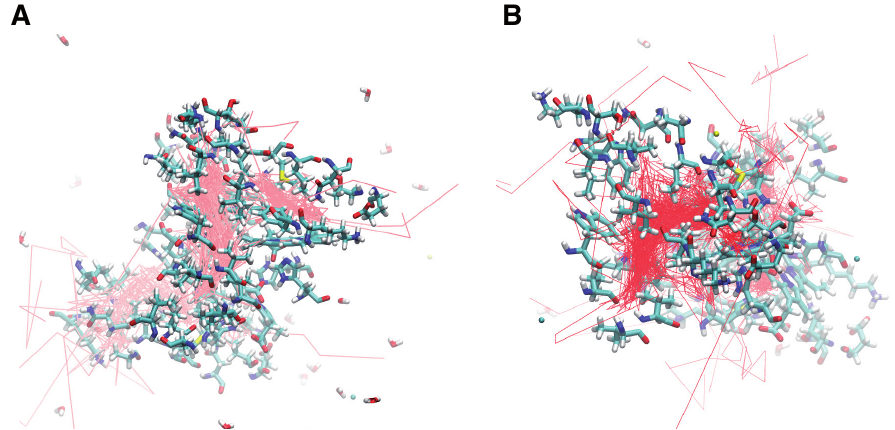
Figure 6. A. I114F trajectories showing the oxygen escape paths in pink. B. I25W trajectories showing the oxygen escape paths in red. The labeled residues can be compared to the internal cavity residues of the B, Xe4, Xe2, and Xe1 cavities shown in Figure